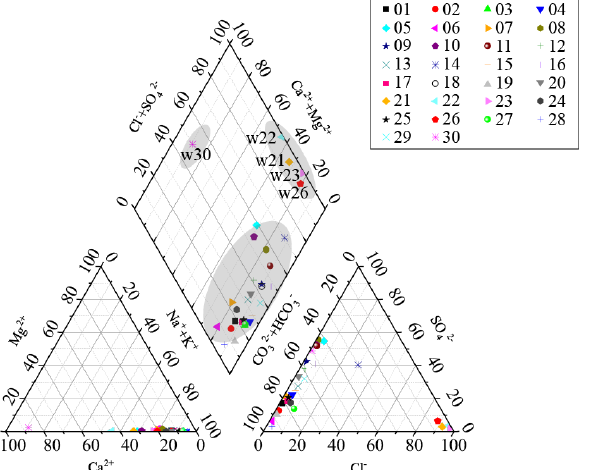
Figure 2. Piper diagram of sample thermal springs. The hot spring samples can be divided into three clusters according to the main ions. Among them, W30 obviously deviates from the others, whereas W21, W22, W23 and W26 have a similar chemical composition; the other 25 samples form a unique and the major